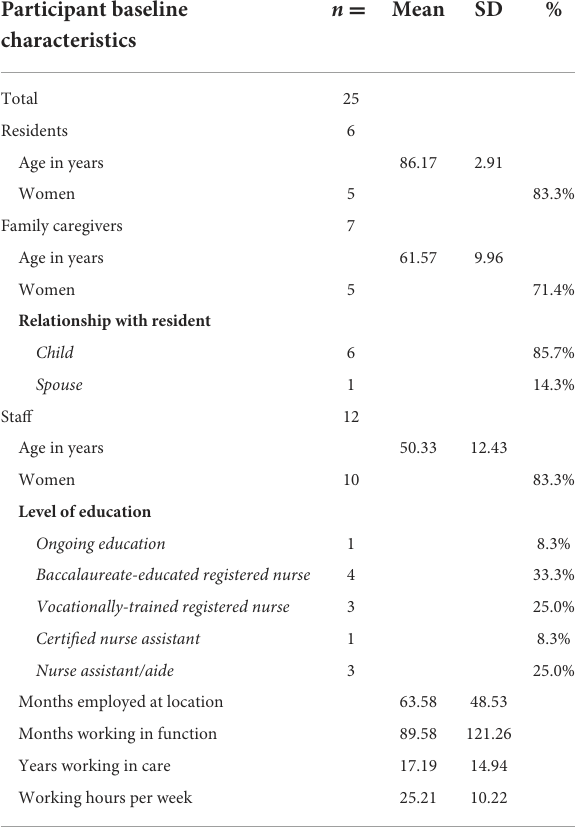
TABLE 1 Baseline characteristics of interview